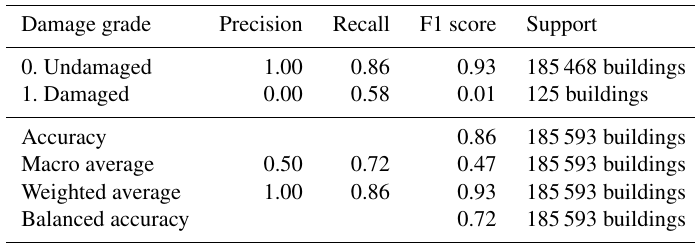
Table 7. Test-set performance metrics for binary classification for the 2020 Puerto Rico earthquake. Damage grade Precision